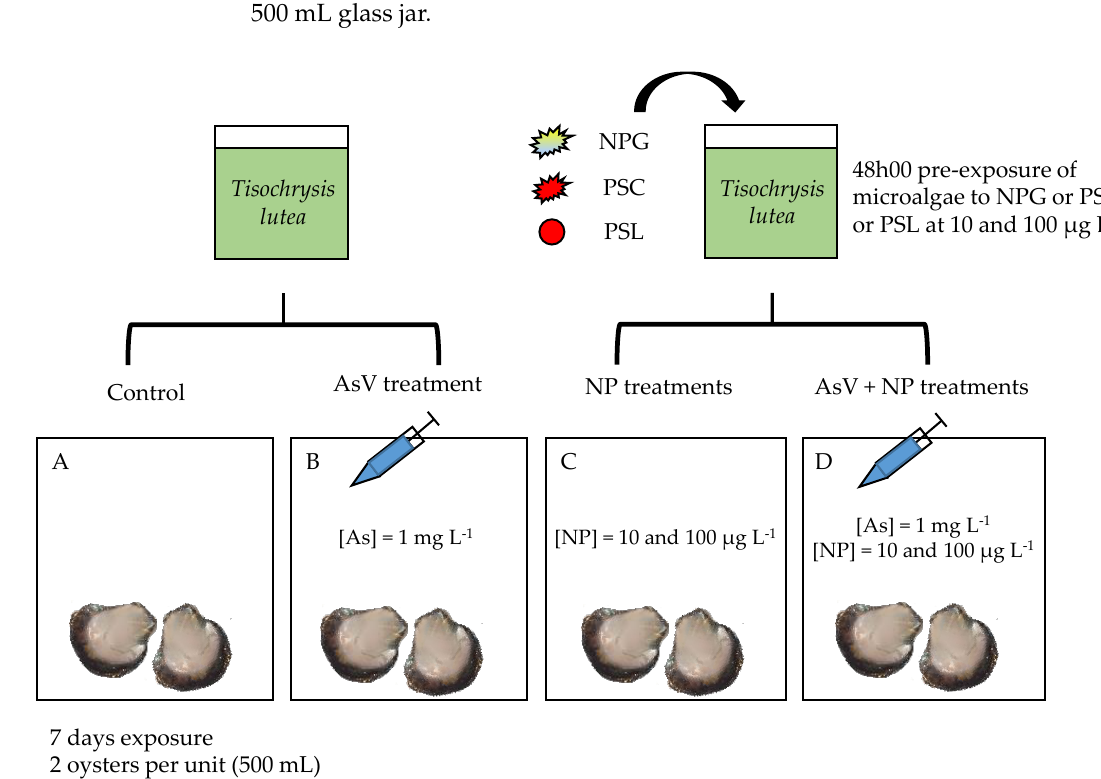
Figure 2. Experimental procedure of I. alatus trophic exposure. Condition ( A ) corresponds to control. Arsenic injections were performed at day 0 in treatments ( B , D ). NPs were added through pre-exposed microalgae feeding, one day out of two in treatments ( C , D ). NP refers to individual NPG, PSC, or PSL treatments.